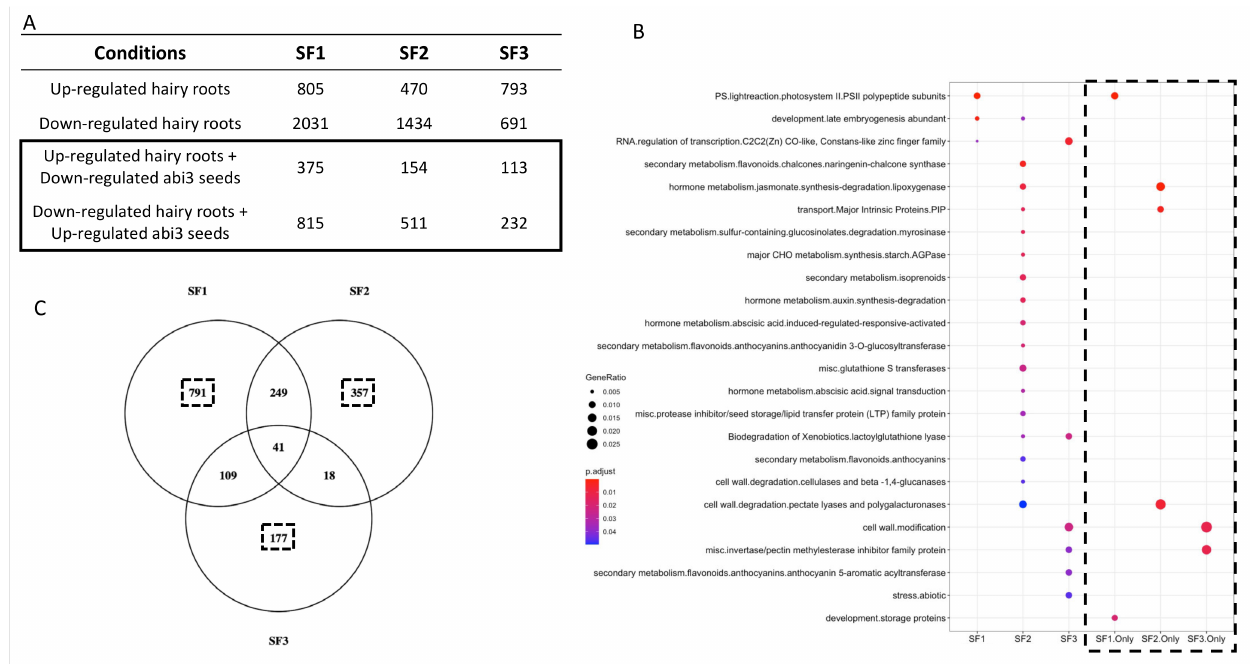
Figure 3. Gene cluster specificity of different splicing forms. ( A ) Number of genes differentially expressed in hairy roots overexpressing the different ABI3 splicing forms and number of genes potentially regulated by ABI3 splicing isoforms when combining DEG results from ectopic expression and loss-of-function approaches. ( B ) Functional enriched Mapman terms from gene clusters regulated by SF1, SF2, and SF3 identified from the combination of ectopic expression and loss-of-function approaches. The size of the dot represents the gene count. A hypergeometric test was used for statistical analysis, and the p -values from the tests were converted to false discovery rate (FDR)-corrected p -values as shown in colors, with the red color being more significant than the blue color. The same analysis (highlighted by a black dashed square) was performed using the genes specifically regulated by each splicing isoform according the Venn diagram (SF1 only, SF2 only, and SF3 only). ( C ) Venn diagrams of different gene clusters regulated by SF1, SF2, and SF3. Numbers with black dashed squares represent the specific gene clusters regulated by each splicing isoform used to perform ORA of SF1 only, SF2 only, and SF3